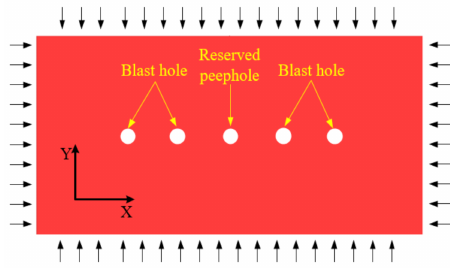
Figure 6. Numerical simulation model. Table 3. Simulation scheme of single quantity comparative analysis.